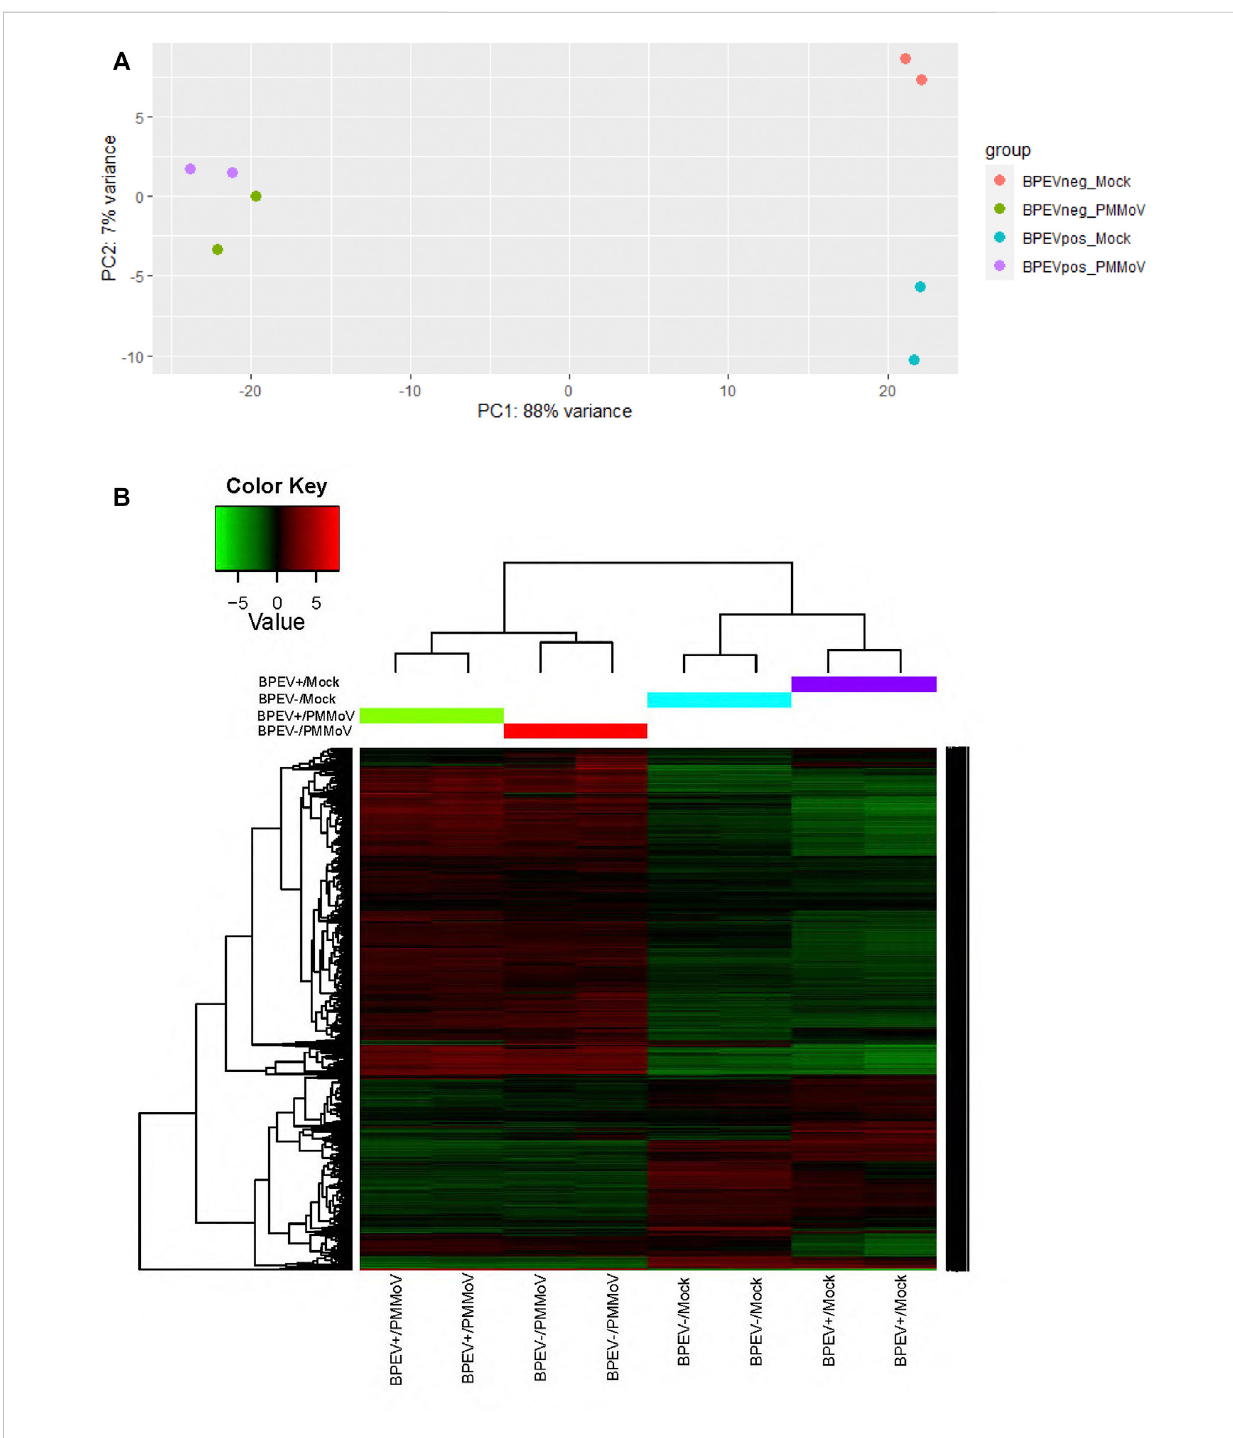
FIGURE 1 (A) Principal component analysis (B) Heat map of the differentially expressed genes of selected libraries from the RNA-seq of two bell pepper near- isogeniclines.Redandgreenindicateup-anddownregulatedgenes,respectively( p < 0.1).BPEV+=infectedwithbellpepperendornavirus,BPEV-=free of bell pepper endornavirus, and PMMoV = pepper mild mottle